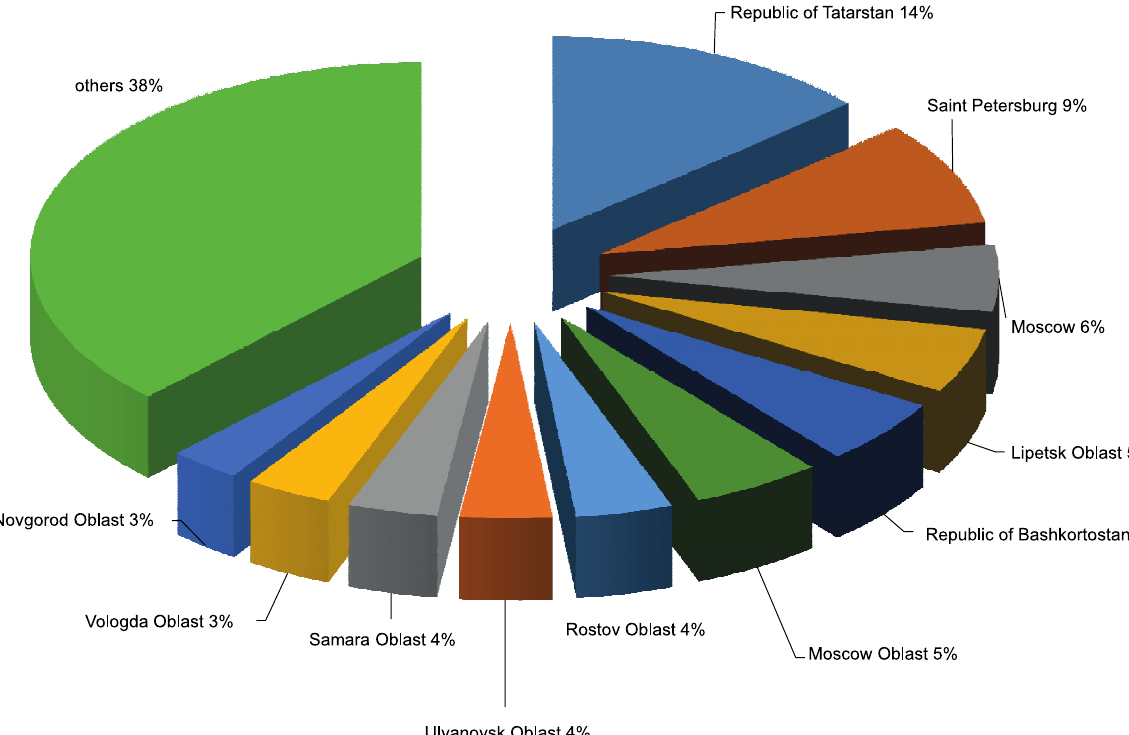
Fig. 2. Number of cluster participants in Russia by regions in 2017 (in %). The total number of participants: 3442. Source: own compilation based on: Karta klasterov